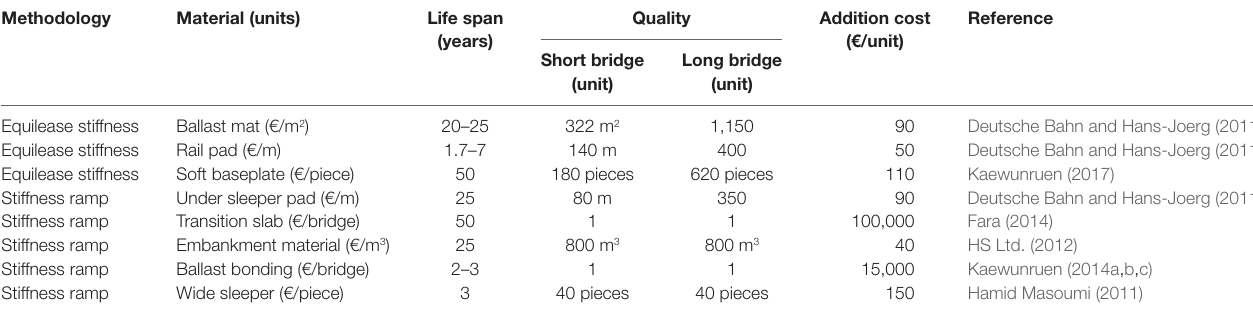
TaBle 2 | Assumptions of additional cost of materials.